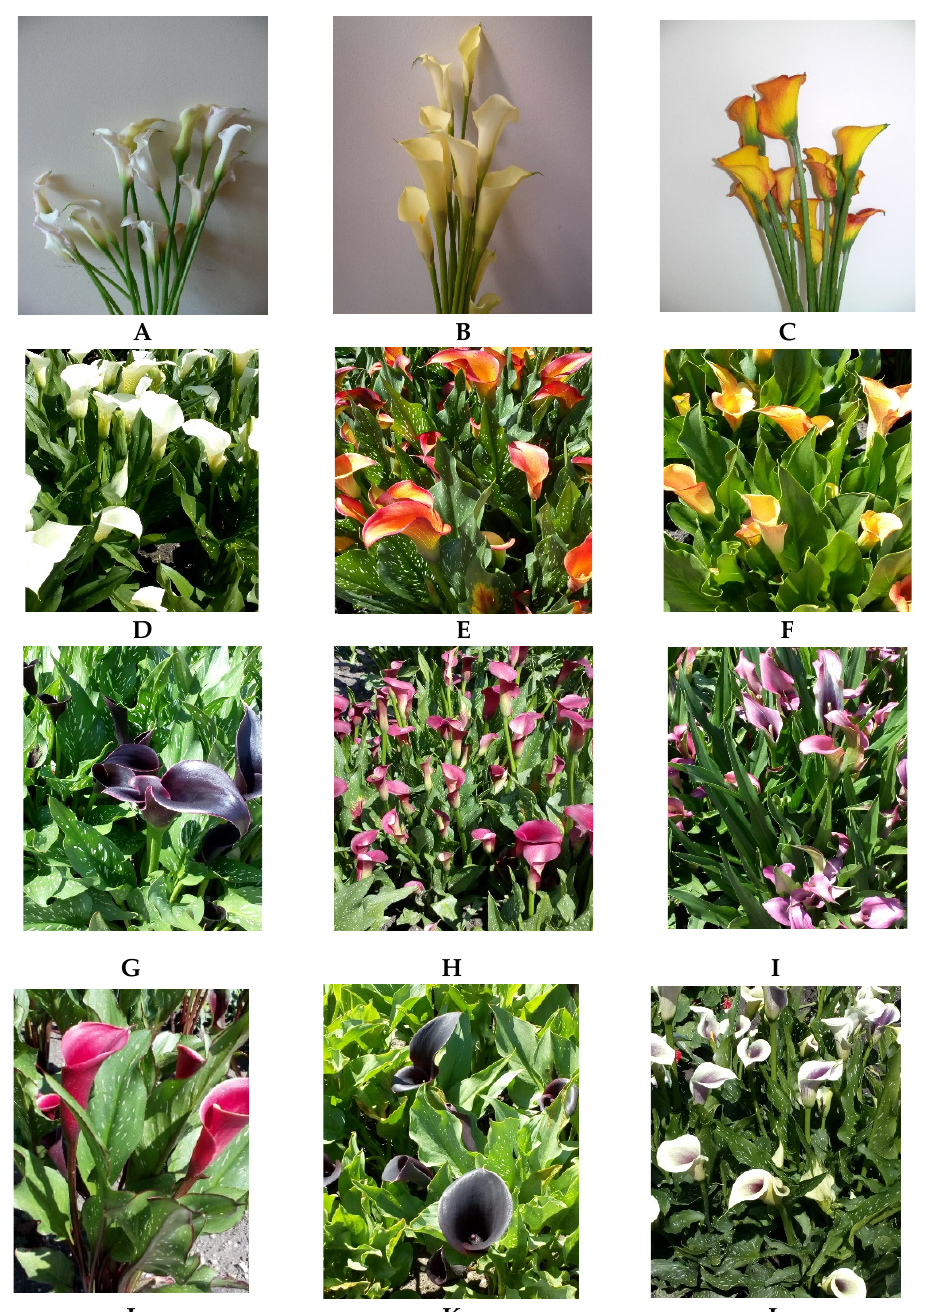
Figure 1. Zantedeschia cultivars: ( A )—‘Albomaculata’, ( B )—‘Black-Eyed Beauty’, ( C )—‘Mango’, ( D )—‘Siberia’, ( E )—‘Morning Sun’, ( F )—‘Mercedes’, ( G )—‘Cantor’, ( H )—‘Le Chique’, ( I )—‘Lavender Gem’, ( J )—‘Red Charm’, ( K )—‘Black Art’, ( L )—‘Picasso’ (Beata Janowska 2010–2017).